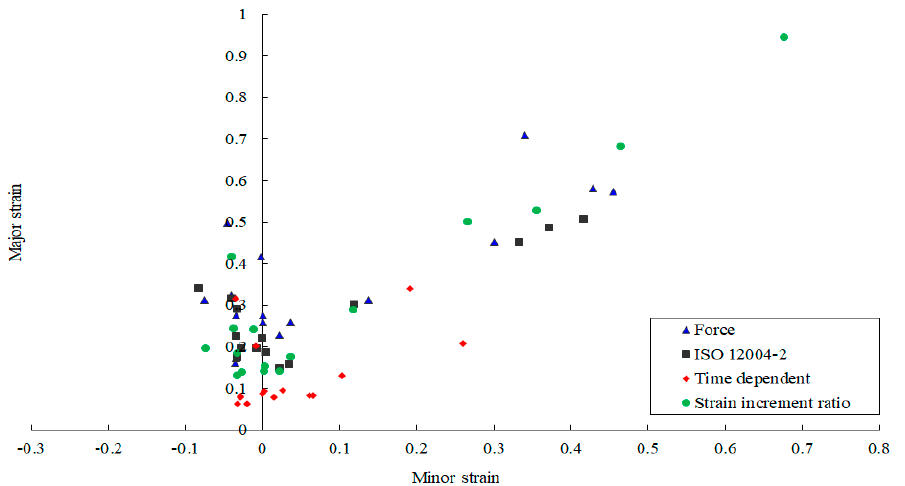
Figure 8. The FLCs of the Marciniak test with different failure